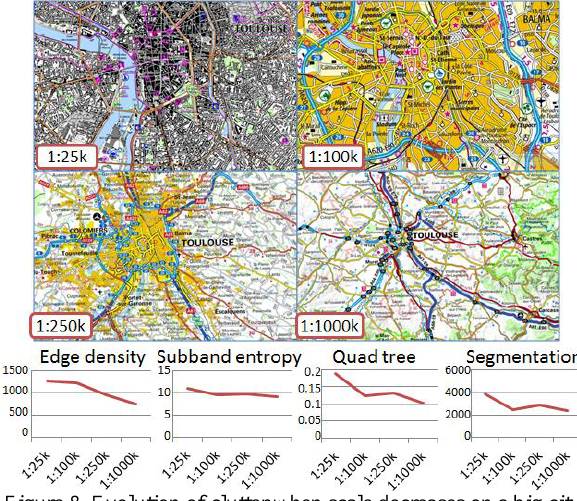
Figure 8. Evolution of clutter when scale decreases on a big city area